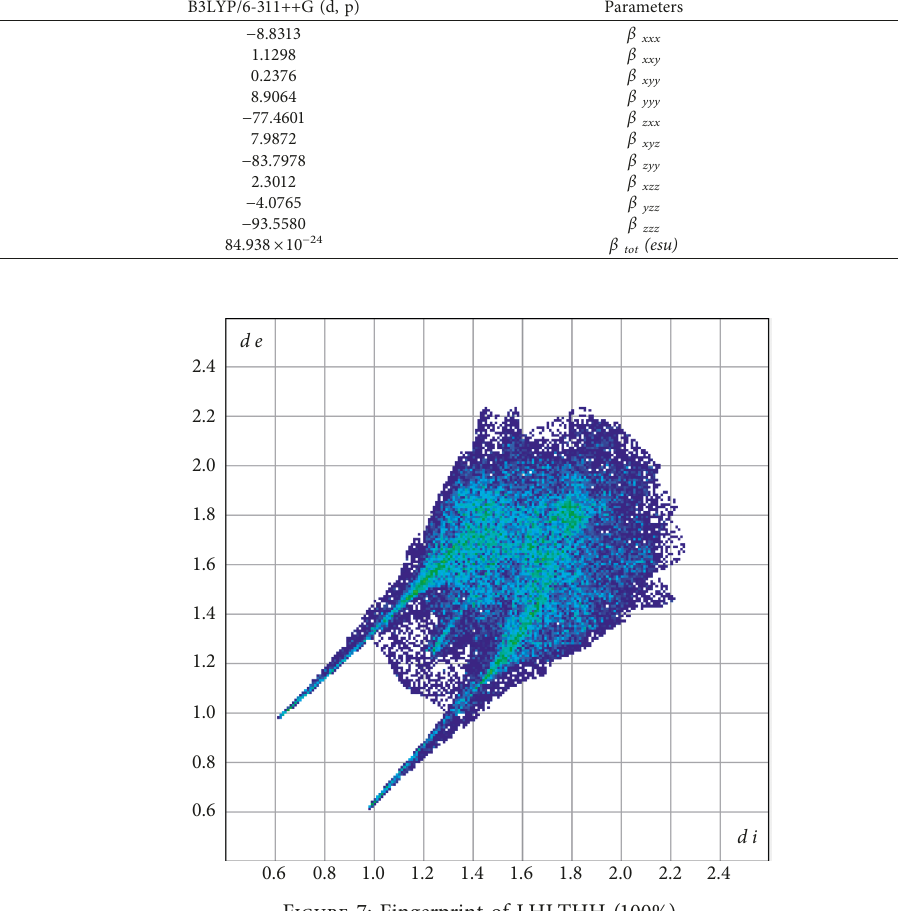
Figure 7: Fingerprint of LHLTHH